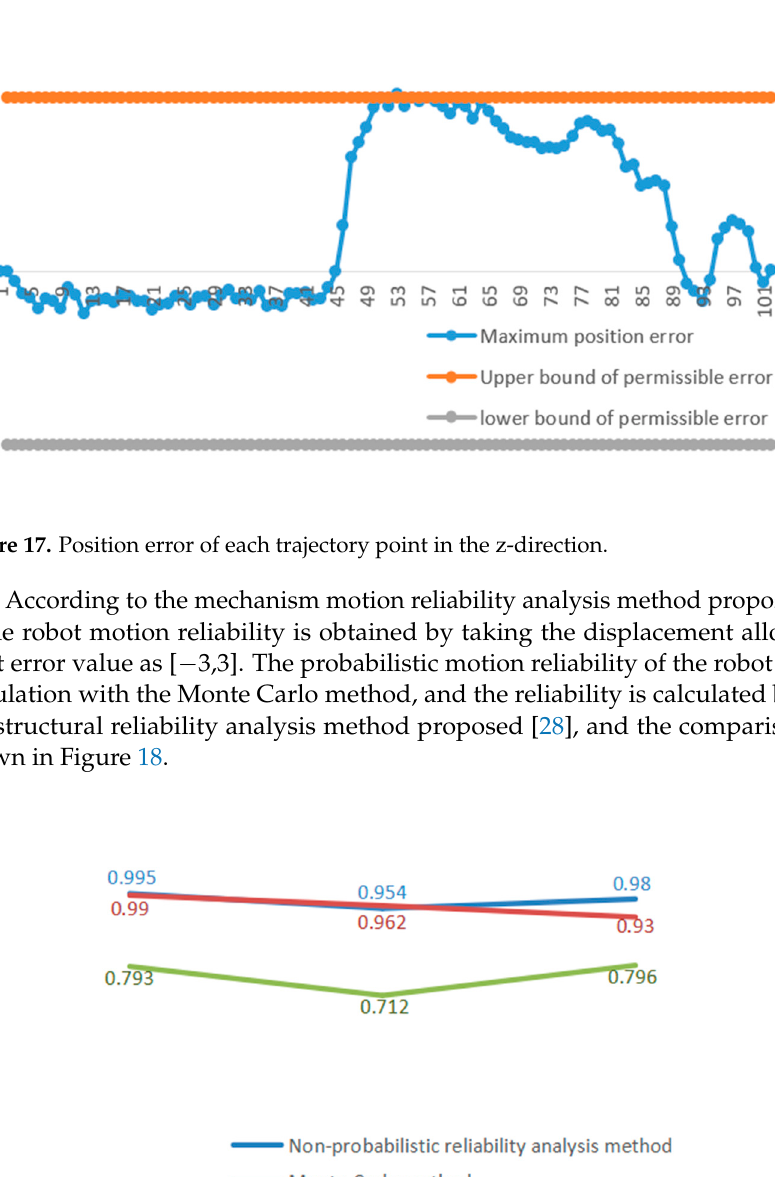
Figure 16. Position error of each trajectory point in the y ‐ direction.